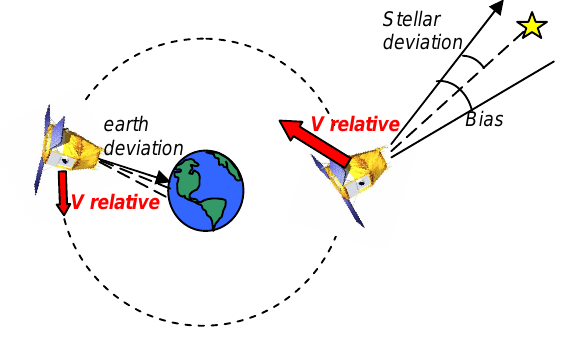
Figure 4: Light-aberration principle